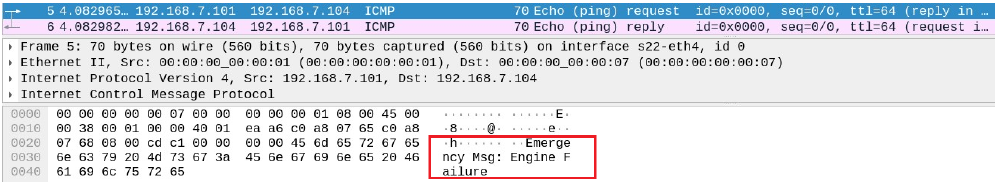
Figure 30. Scapy: packet creation.